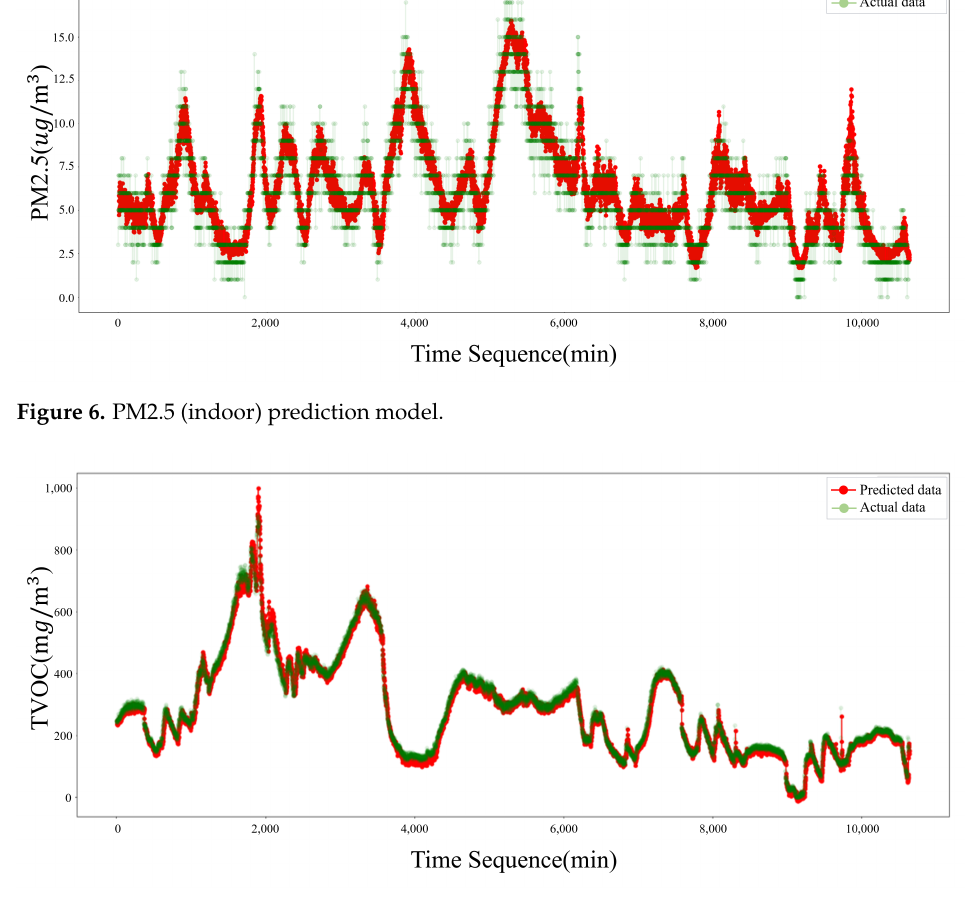
Figure 7. TVOC prediction